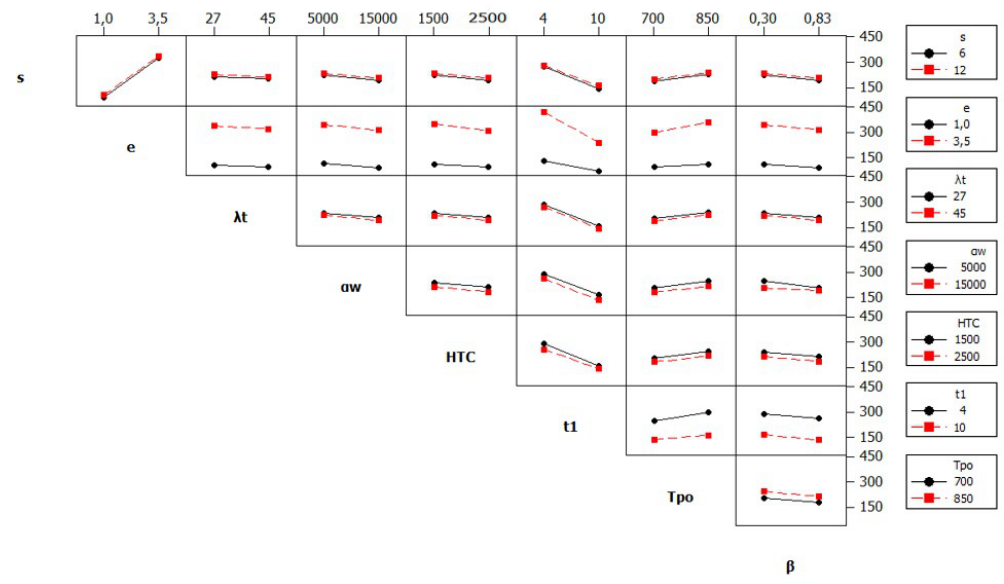
Figure 7. Main interaction chart for Tipt110 .